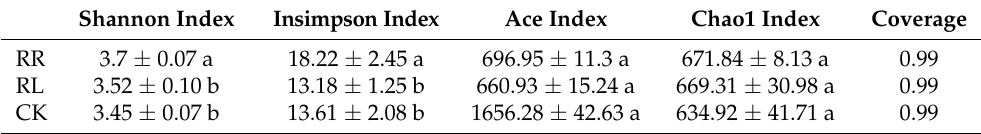
trend as soil bacteria (Table 4). Table 4. Soil fungal alpha diversity in rhizospheres of oilseed rape under RR, RL and CK systems. Shannon